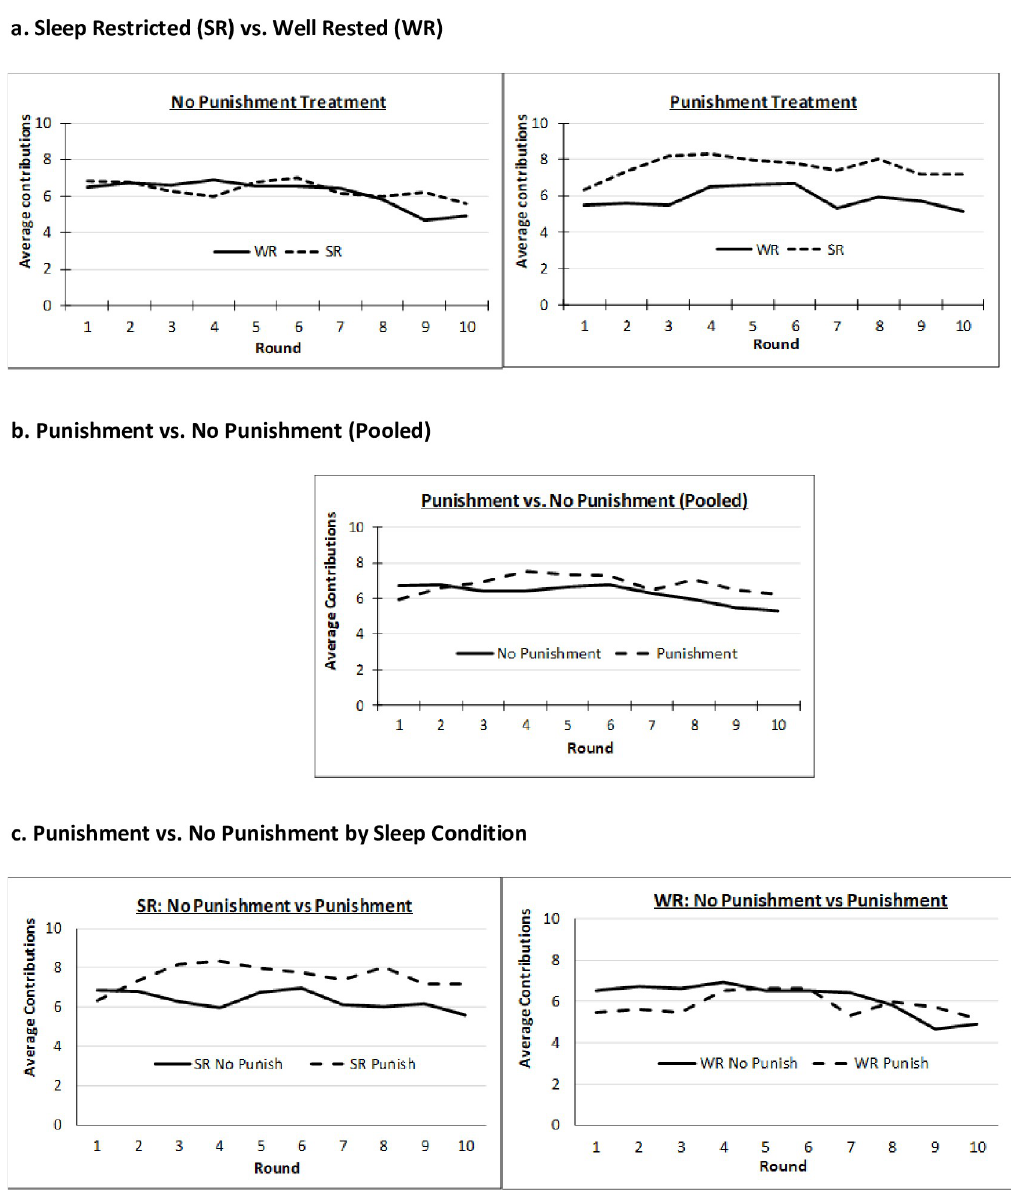
Fig 2. Average contribution levels (Compliant subjects